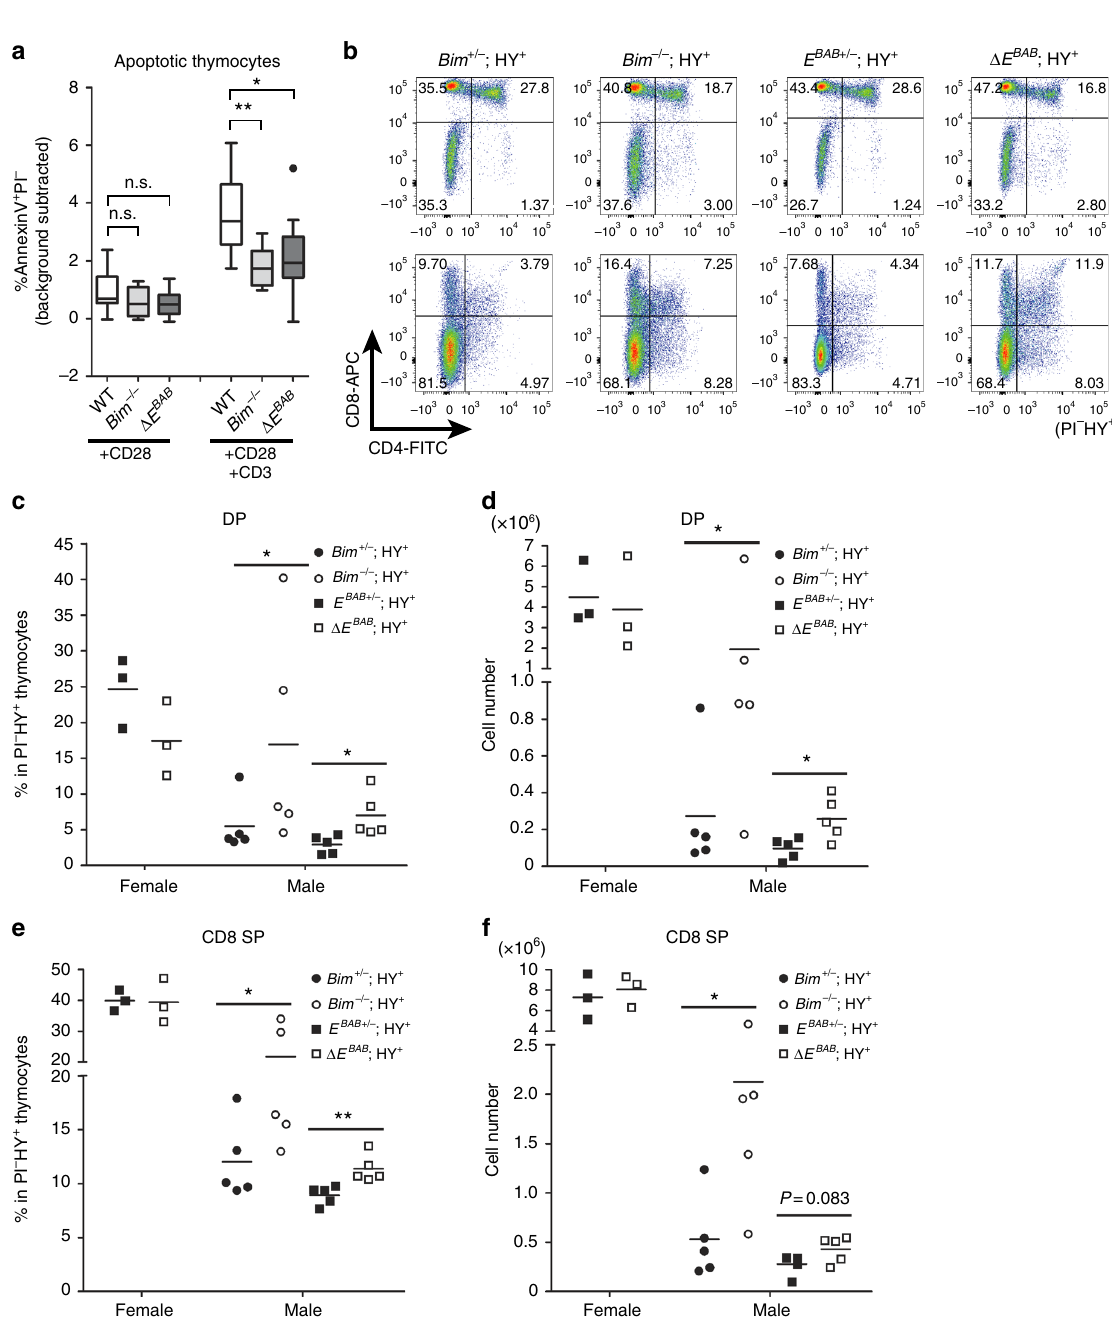
Fig. 3 E BAB contributes to depletion of high af fi nity TCR clones in ex vivo TCR stimulation and the HY tg models. a Annexin V + Propidium Iodide (PI) − fraction of total thymocytes stimulated with anti-CD3 and anti-CD28 antibodies (10 µ g/ml) for 9 h. The percentage in mock sample (i.e., background) is subtracted. Data are pooled from 11 independent experiments ( n = 3 WT – Δ E BAB littermate pairs, n = 3 sex-matched WT – Δ E BAB pairs, n = 1 WT – Bim − / − littermate pair, n = 1 sex-matched WT – Bim − / − pair, n = 3 sex-matched WT – Bim − / − – Δ E BAB trios, 5 – 20 weeks old). Edges of the box are the 25th and 75th percentiles, and error bars extend to the maximum and minimum. Outliers are de fi ned as the data point that is located outside of q 3 + 1.5( q 3 − q 1 ) and q 1 − 1.5( q 3 − q 1 ), in which q 1 and q 3 are the 25th and 75th percentiles. b CD4 versus CD8 fl ow cytometric analysis of PI − HY-TCR + thymocytes from female and male HY tg mice. The number in the plot is representative percentage of each gate. c − d DP thymocyte proportion ( c ) and cell numbers ( d ) of PI − HY-TCR + thymocytes from female and male HY tg mice. e , f CD8 SP thymocyte proportion ( e ) and cell numbers ( f ) of PI − HY-TCR + thymocytes from female and male HY tg mice. Data are representative of ( b ), or pooled from ( c – f ), six independent experiments ( n = 1 Bim + / − ; HY + and Bim − / − ; HY + female mice, n = 5 Bim + / − ; HY + and Bim − / − ; HY + male mice, n = 3 E BAB + / − ; HY + and Δ E BAB ; HY + female mice, n = 5 E BAB + / − ; HY + and Δ E BAB ; HY + male mice, 6 – 8 weeks old). Each symbol in ( c – f ) represents an individual mouse; small horizontal lines indicate the means. n.s. not signi fi cant ( P ≥ 0.05); * P < 0.05, ** P < 0.01 (unpaired one-tailed Student ’ s t test or Mann – Whitney U test for Bim KO data, and unpaired two-tailed Student ’ s t test for Δ E BAB